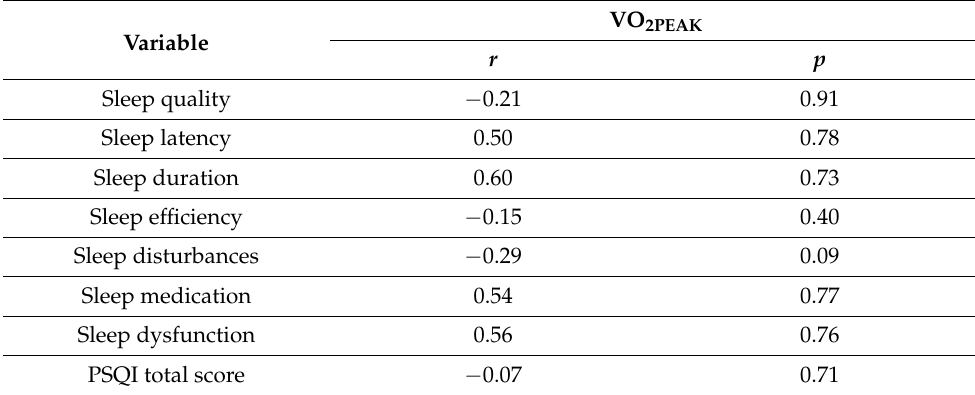
Table 3. Correlation analysis between VO 2PEAK and sleep quality index (PSQI).